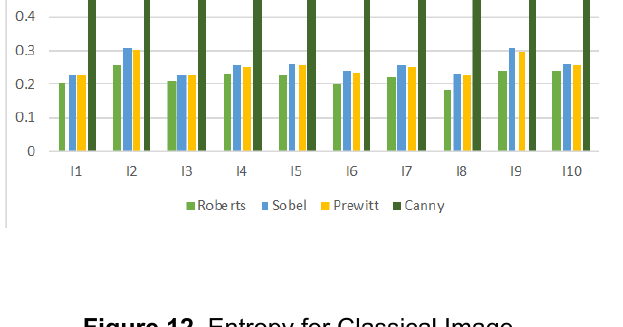
Figure 12. Entropy for Classical Image Segmentation Techniques